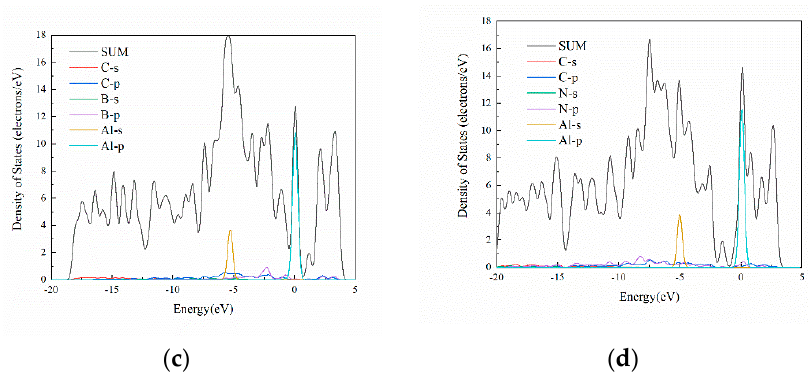
Figure 4. Density of states: ( a ) pristine graphene with adsorbed Al atom; ( b ) VG with adsorbed Al atom; ( c ) B-doped graphene with adsorbed Al atom; ( d ) N-doped graphene with adsorbed Al atom.